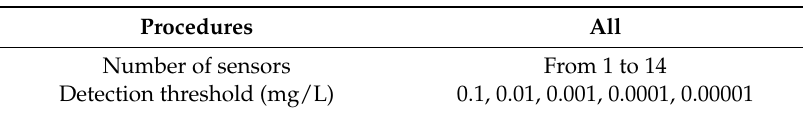
Table 2. Performed tests.